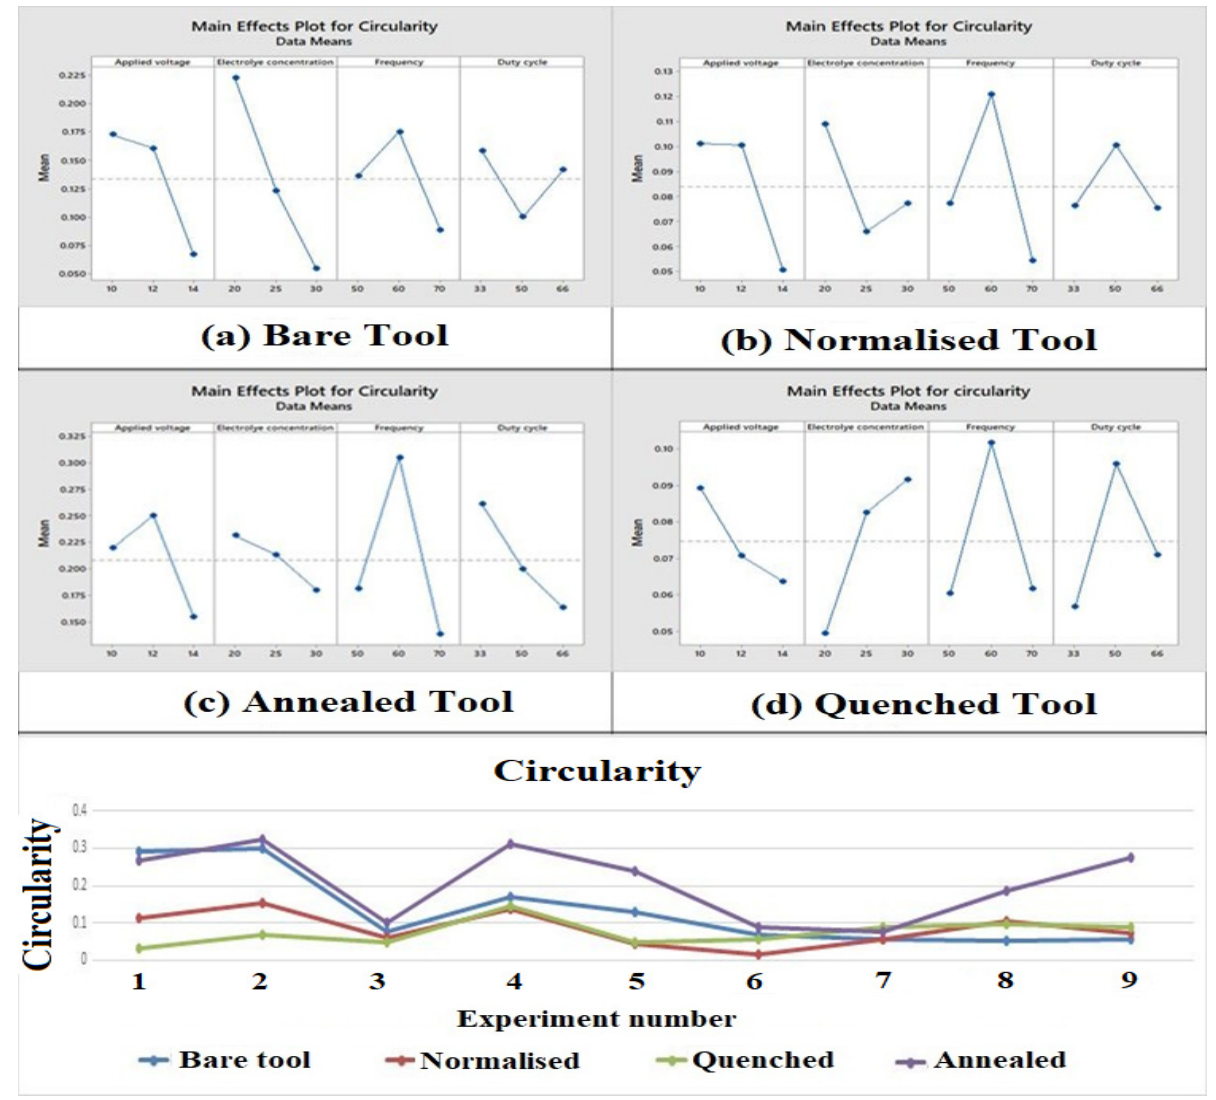
Figure 7. Main effect plots and comparison plot of circularity for tool electrodes. (a) Bare tool; (b) Normalized tool; (c) Annealed tool; (d) Quenched tool.